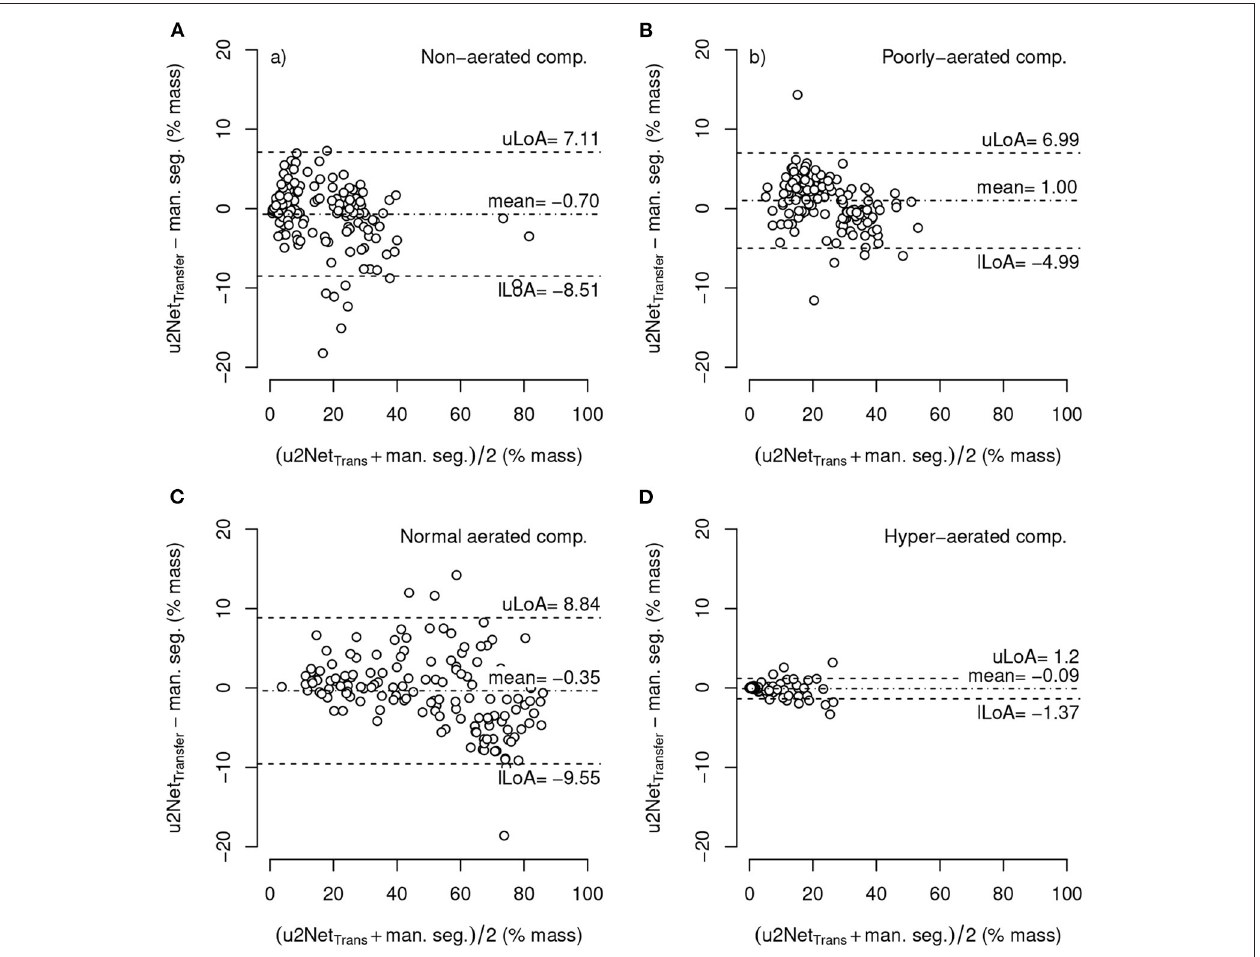
FIGURE 6 | Bland-Altman-plot of relative mass non-aerated (A) , poorly-aerated (B) , normally-aerated (C) and hyper-aerated (D) compartments using mask segmented by u 2 Net Transfer compared to manual segmentations; with upper and lower limits of agreement (mean ± 1.96 · standard deviation) uLoA and lLoA ,